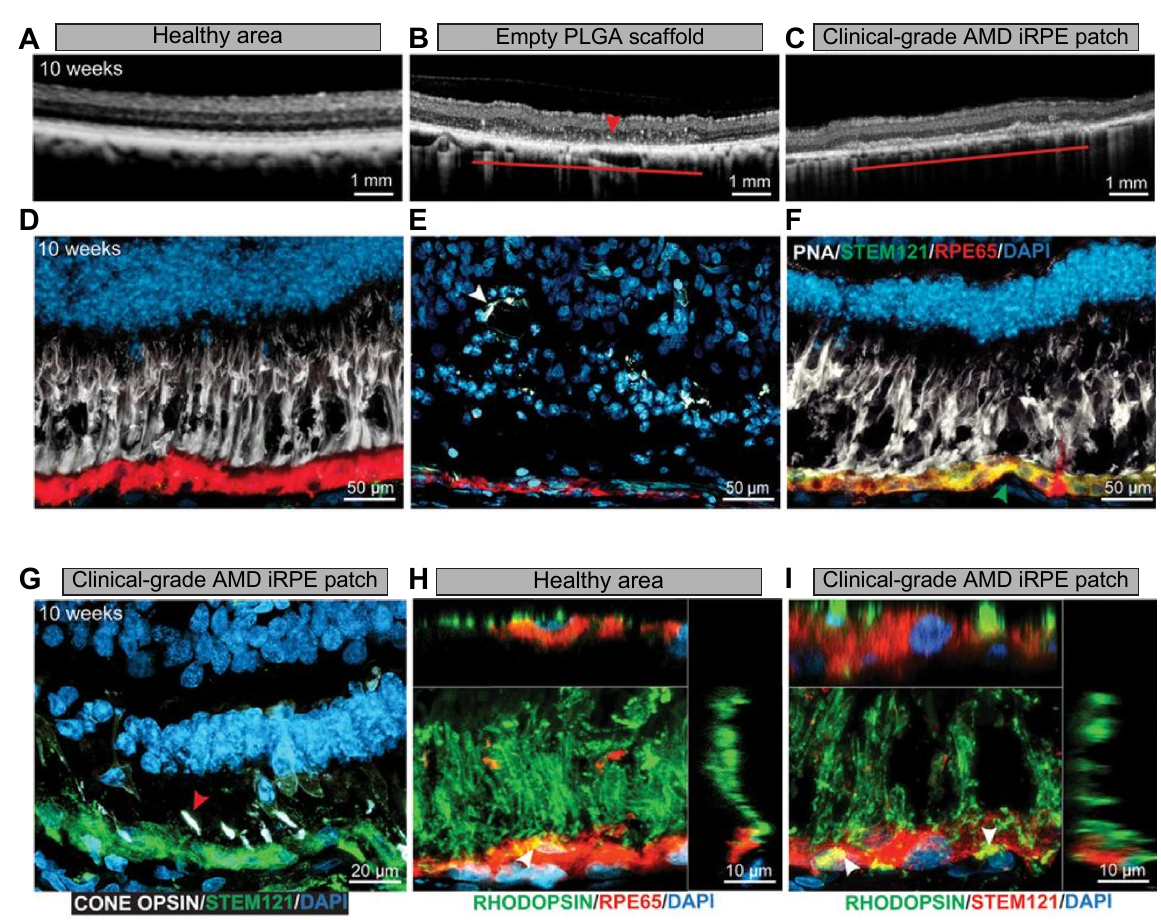
Figure 6. Integration and functional assessment of AMD-patient-derived iRPE patch in laser-induced porcine retinal degeneration model. ( A–C ) OCT images of healthy retina and retina transplanted with PLGA scaffold or AMD-iRPE patch. The horizontal line shown in ( B , C ) indicates the transplanted scaffold over an area of laser-induced RPE ablation. ( D–F ) The retinal sections were stained with PNA (white), STEM121 (green), and RPE65 (red). The green arrow in ( F ) indicates the integration of AMD-iRPE (green, STEM121) in the injured porcine retina (red, RPE65). The white arrowhead in ( E ) shows the presence of retinal tubulations. ( G ) The retinas were immunostained for red, blue, and green cone opsins (white) and STEM121 (green) to observe the presence of pig cone receptors above human iRPE (red arrow). ( H–I ) The retinas were immunostained with rhodopsin and RPE65 or STEM121. The white arrow shows the presence of phagocytosed photoreceptor outer segments in both the healthy pig RPE (stained with RPE65) and in human iRPE cells (STEM121). Z-sections show the localization of photoreceptor outer segments. Reprinted with permission from [51]. Copyright The American Association for the Advancement of Science, 2019.